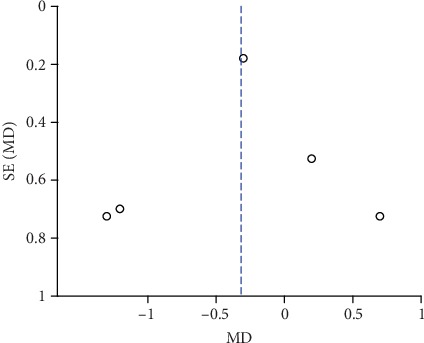
Funnel plot of pain scores at rest at 1 h.